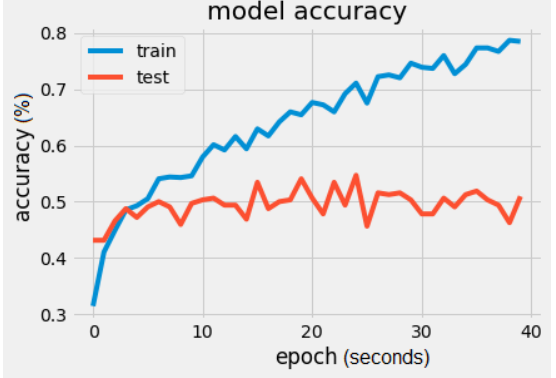
Figure 4. VGG16 model accuracy.